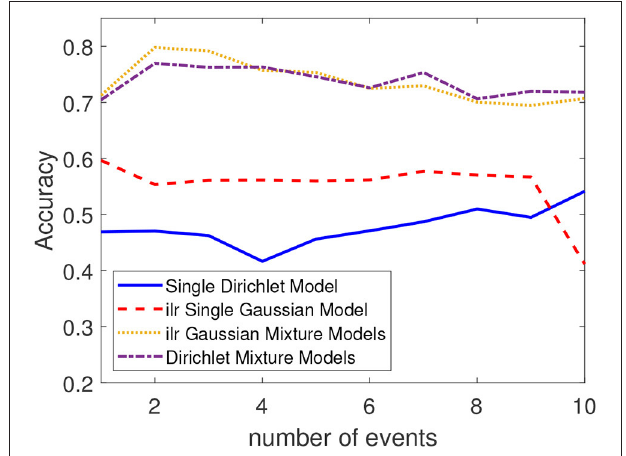
FIGURE 11 | Classification accuracy for each method with respect to the number of events.